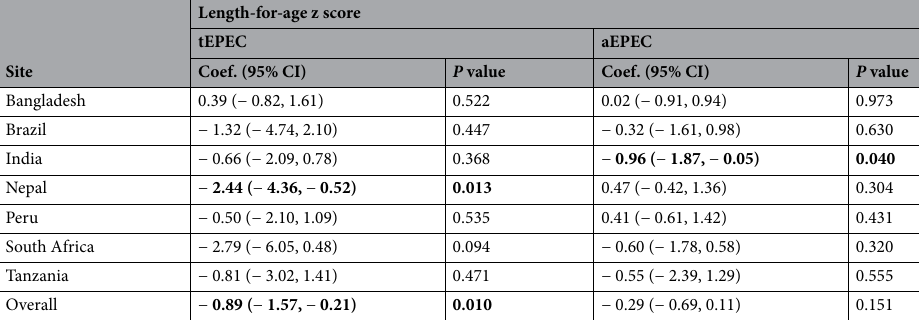
Table 3. Genomic subtypes of EPEC and burden on child growth at 24 months across each of the study sites (except Pakistan) from November 2009 to February 2012. Adjusted in the linear regression model for sex, birth weight, exclusive breastfeeding, WAMI Index (water/sanitation, assets, maternal education, and income); enrollment length-for-age z score; maternal BMI; poultry and cattle in house, a mother has less than 3 living children, average serum zinc level, average AGP (alpha-1-acid glycoprotein) level, presence of co-pathogens ( Campylobacter, LT-ETEC, ST-ETEC, Shigella/ EIEC, and Giardia) and site for overall estimate. Coef. Coefficient, CI confidence interval.